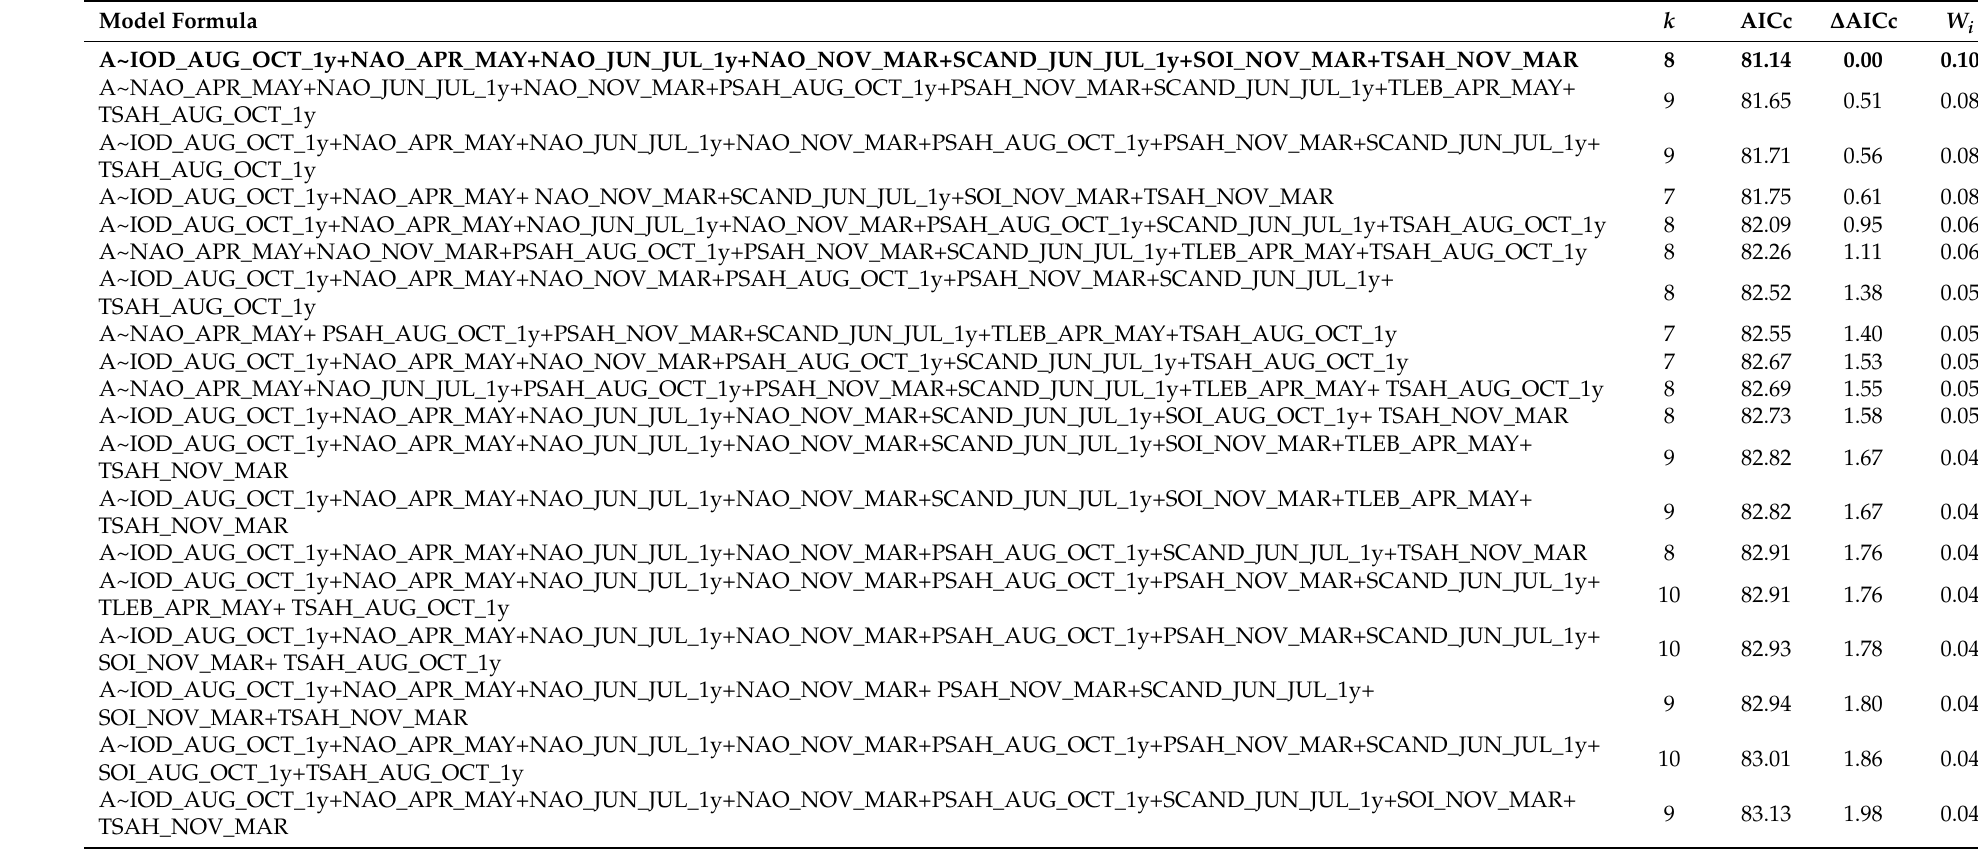
Table A24. Model selection procedure by “all subsets”, according to AICc, from the full model of the relationship between the 15 climate variables and the year and the overall timing of migration as measured by Annual Anomaly (AA) for the Willow Warbler Phylloscopus trochilus caught at Bukowo, Poland, in 1982–2017. Symbols as in Table A19. The best model, discussed in the text, in bold